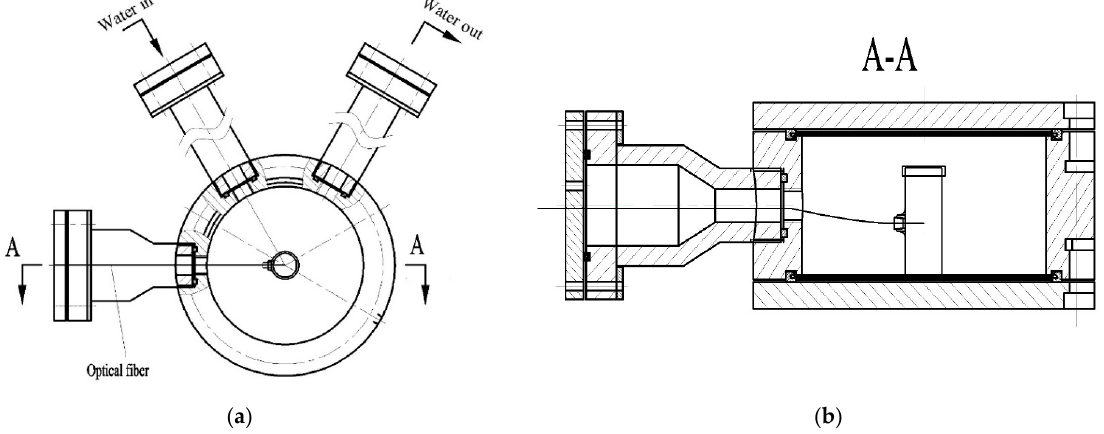
Figure 3. Schematic of the sterilization kettle ( a ) and partial section view of the sterilization kettle ( b